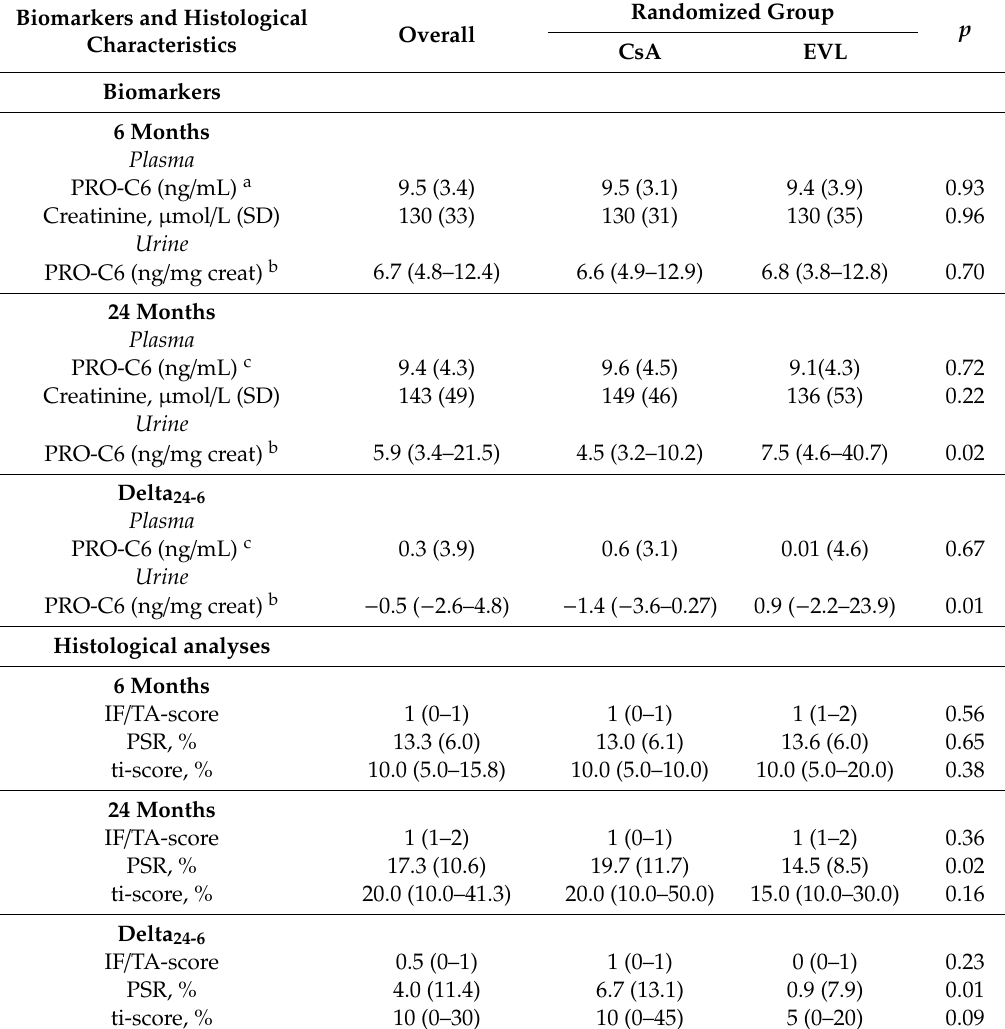
Biomarkers and histological characteristics during follow-up of overall KTRs and randomization